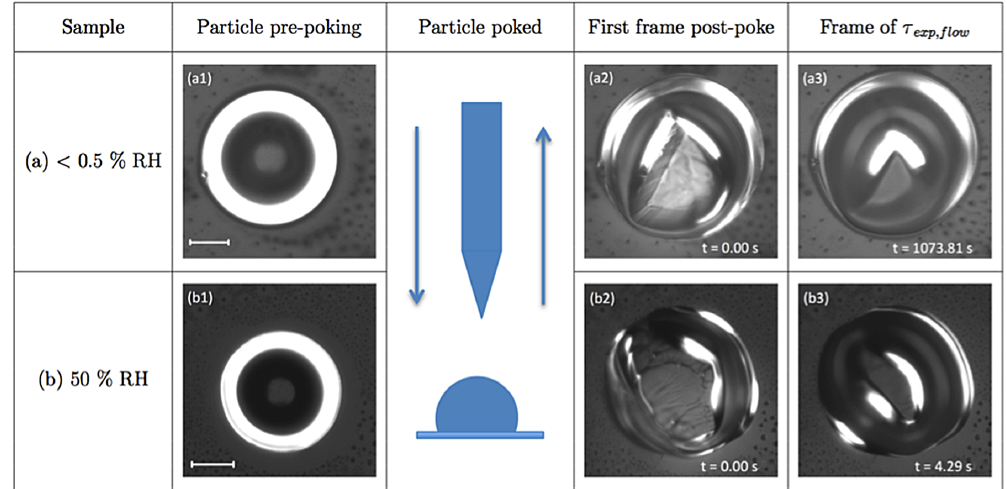
Figure 2. Optical images recorded during typical poke-and-flow experiments of whole SOM produced at a production mass concentration of 520µgm − 3 being poked at (a) <0.5%, and (b) 50%, RH. Panels (a1) and (b1) correspond to SOM prior to poking. Panels (a2) and (b2) correspond to the first frame post-poke (i.e. the first frame after the needle has been removed). Panels (a3) and (b3) correspond to images of the experimental flow time, τ exp, flow , the point at which the diameter of the hole at the centre of the torus has decreased to 50% of its original size. Scale bar in panels (a1) and (b1) :